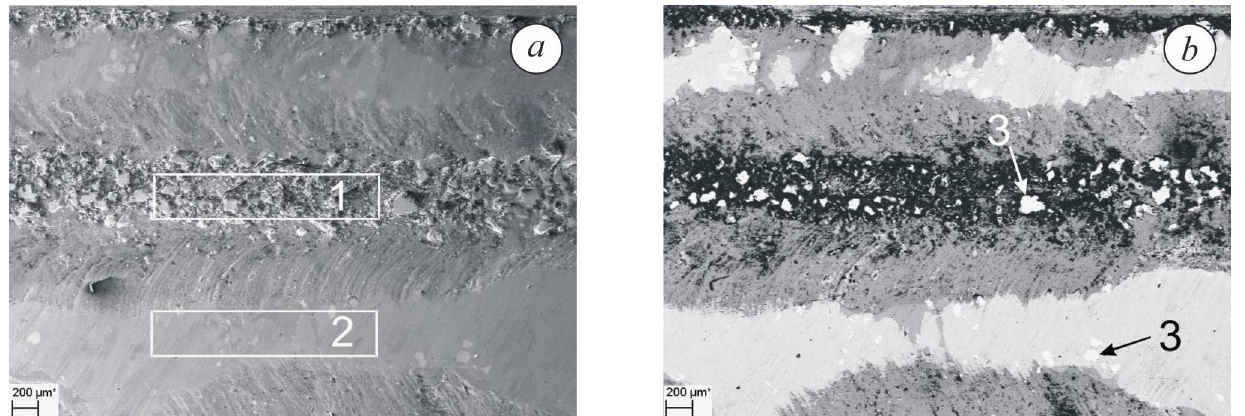
Figure 11. SEM ( a ) SE and ( b ) CZ BSD images of surface microstructure on AISI 420 steel after laser alloying with a plaster of 85Nb + 15% liquid glass and wear testing: the numbers 1 and 2 mark different zones of friction contact, and 3 marks inclusions on wear tracks.